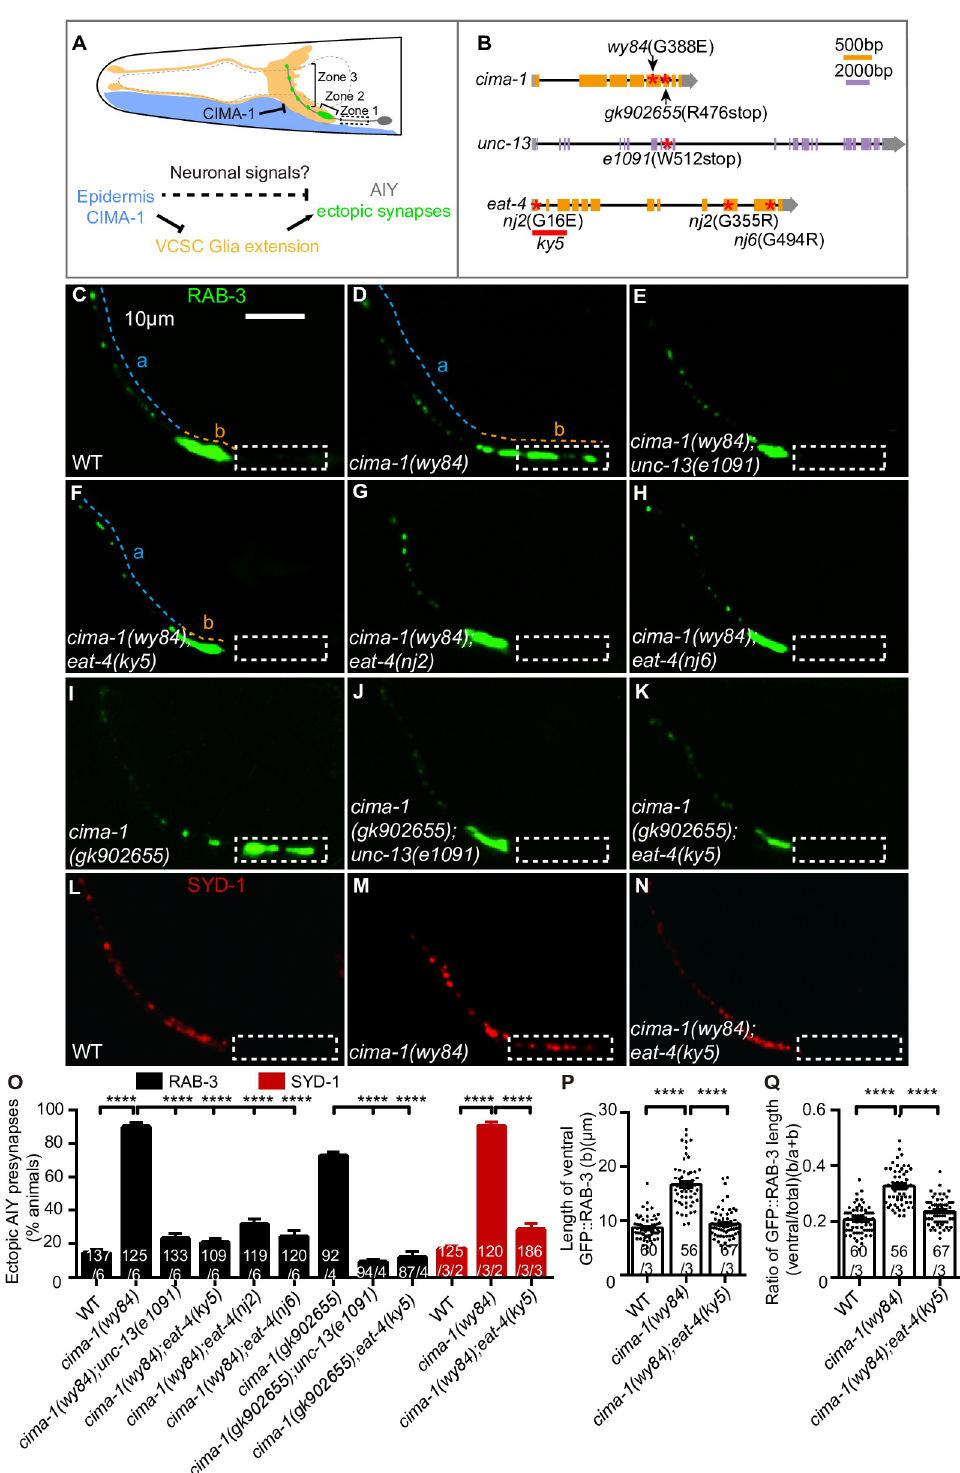
Fig 1. Glutamatergic neurotransmission is required for the AIY ectopic synaptic formation in cima-1(wy84) . (A) A model of cima-1 in epidermal cells (blue) regulating AIY (gray) synaptic position (green) partially through modulating VCSC glia (yellow) morphology. The AIY presynaptic pattern is stereotypic and can be subdivided into three typical zones: the ventral asynaptic zone 1 region (dashed box), the synaptic enriched zone 2 region (skewed bracket), and